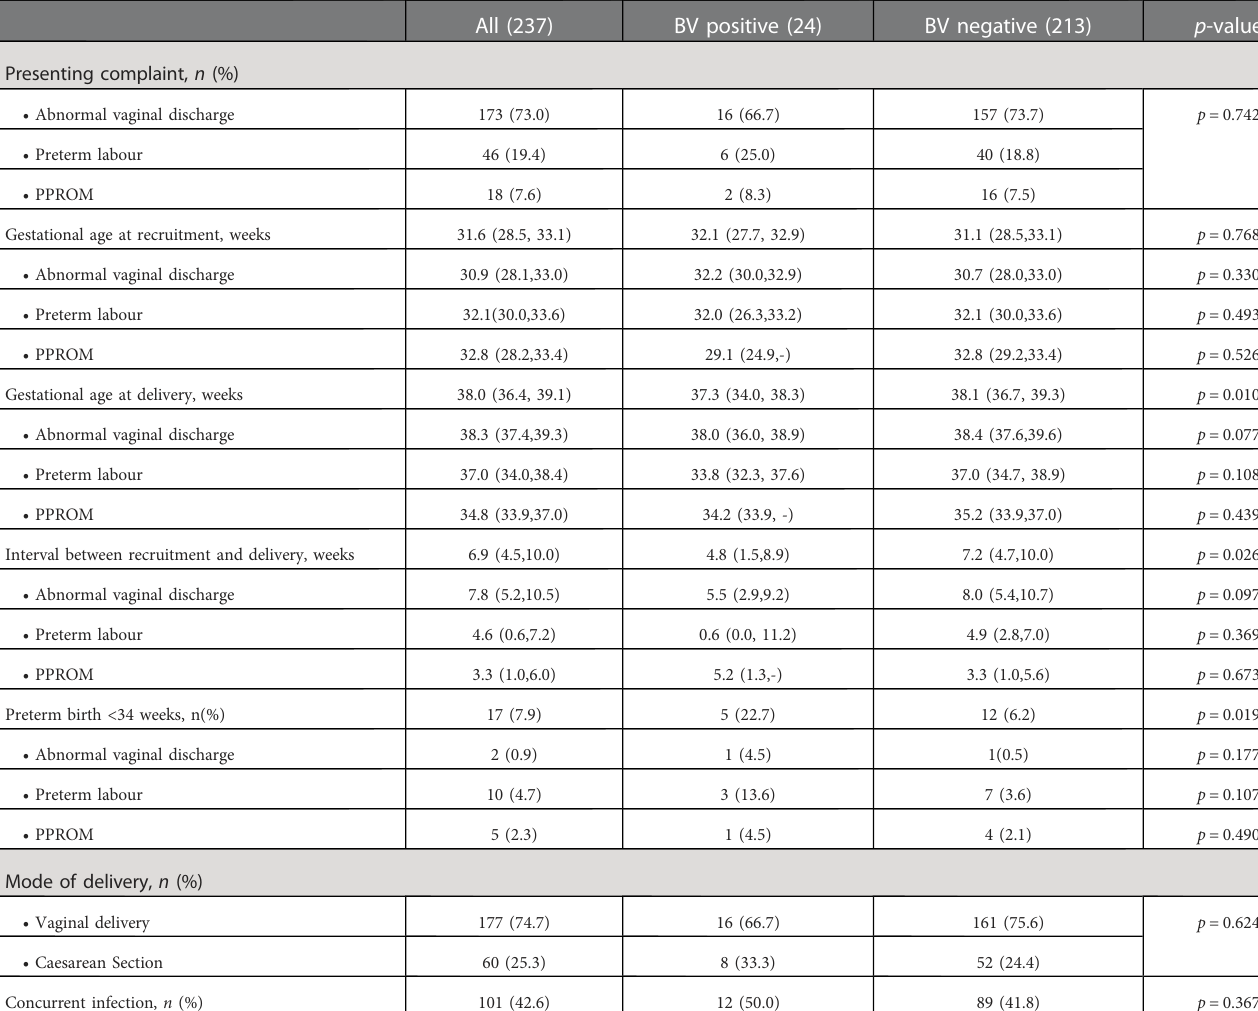
TABLE 2 Patient clinical